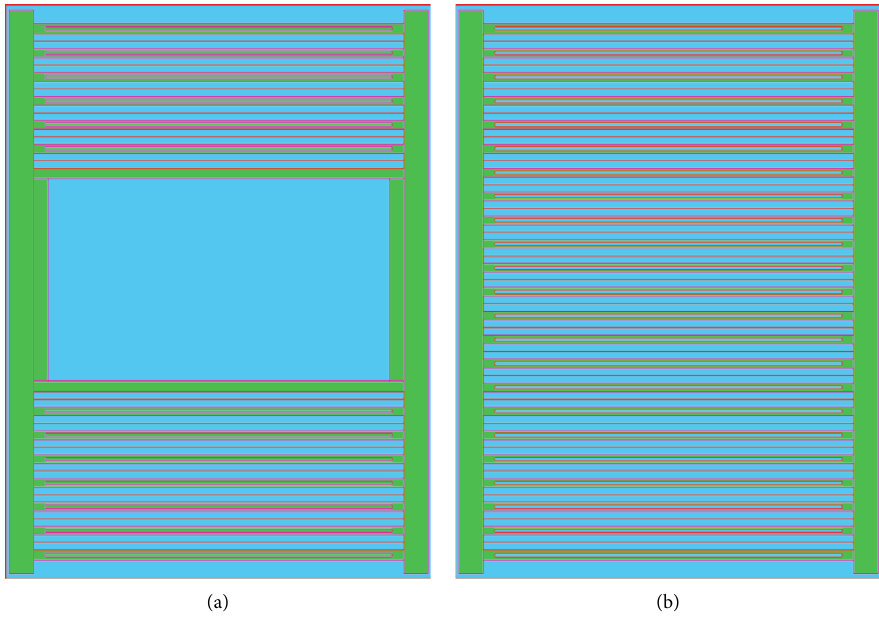
Figure 4: SuperMC model of control fuel element (a) and standard fuel element